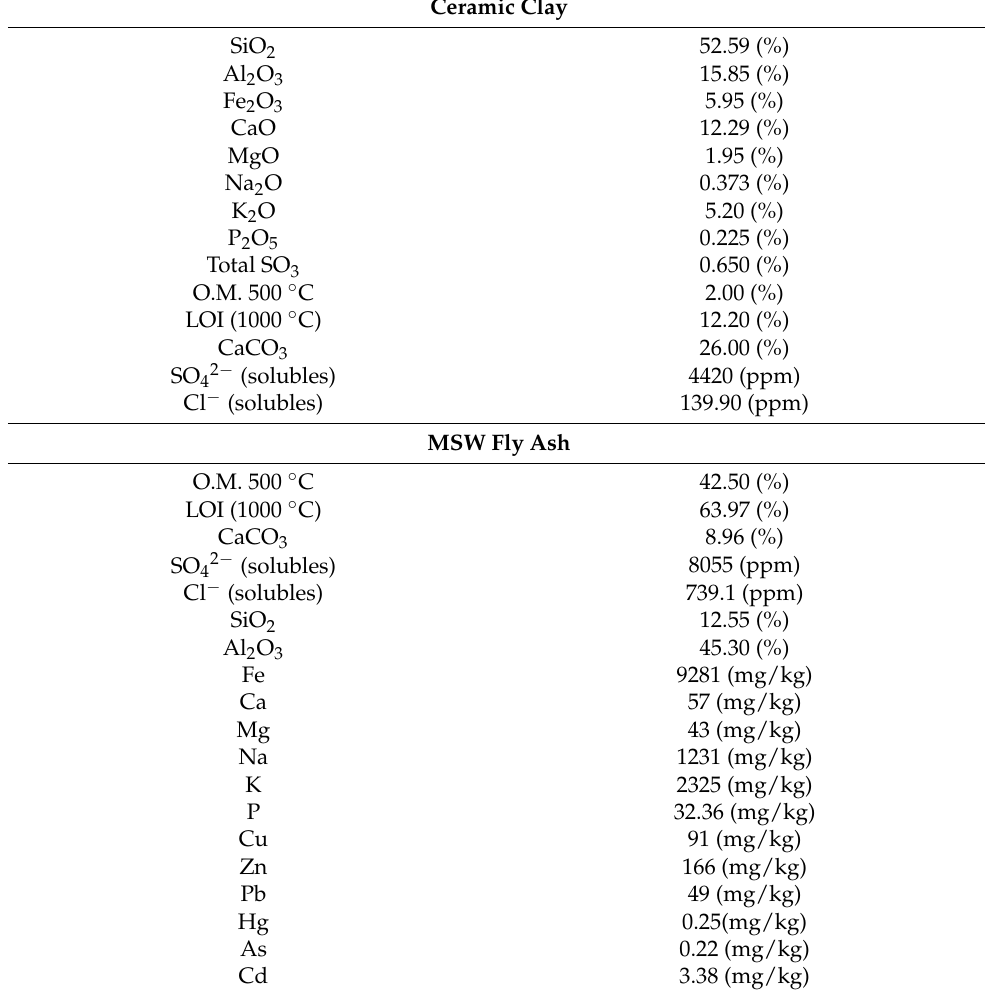
Table 1. Chemical composition of ceramic clay, MSW fly ash and copper sludge used in the formula- tion of